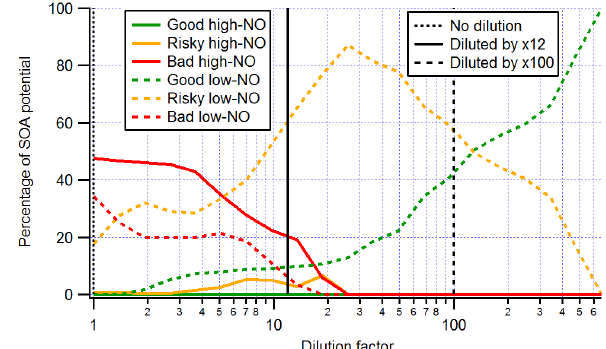
Figure 8. Secondary organic aerosol (SOA) potential (estimated from the total hydrocarbon measurement) in the OFR of Karjalainen et al. (2016) formed during periods of time in the OFR correspond- ing to good/risky/bad high-/low-NO conditions as a function of di- lution factor. Vertical lines denoting dilution factors of 1, 12 (as actually used in that study), and 100 are also